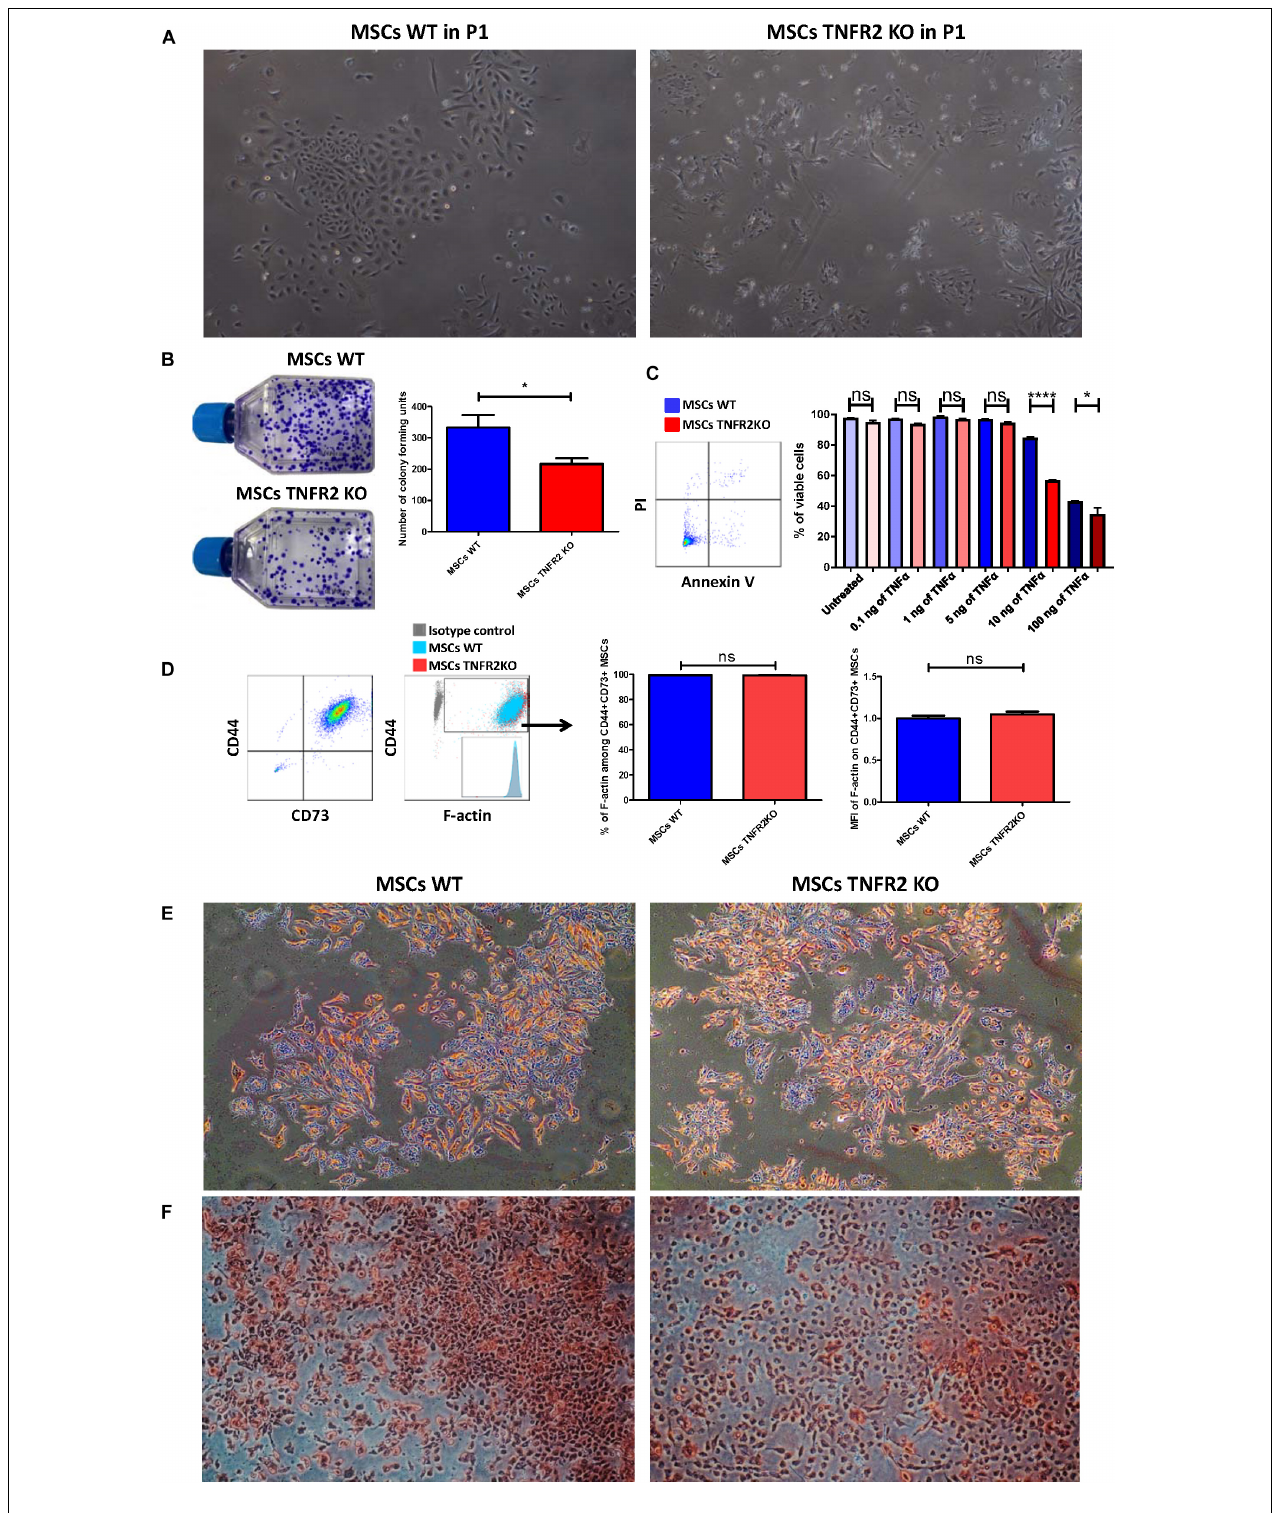
FIGURE 1 | Mesenchymal stem cell (MSC) characterization and differentiation capacity. (A) Wild-type (WT)-MSCs in P1 demonstrate regular fibroblast-like form with spindle-shaped morphology (4 × ), while a more heterogeneous appearance with smaller cytoplasm is observed by their TNFR2 knockout (KO) counterparts in P1 (4 × ). (B) Colony-forming unit (CFU) assay reveals higher efficiency of WT-MSCs to form colony units in comparison with TNFR2 KO-MSCs. Results are collected from two independent experiments ( n = 14). (C) Flow cytometric analysis of MSC viability assessment reveal the equivalent percentage of viable cells